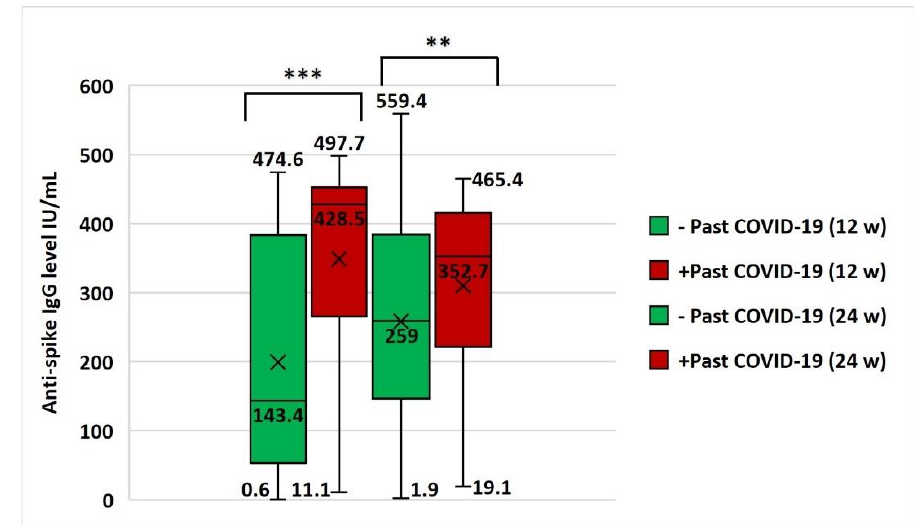
Figure 9. Effect of past COVID-19 infection on antibody immune response after vaccination. Comparison of anti-spike IgG antibody serum level (median and range) between negative ( − ) and positive (+) past COVID-19 infection groups at 12 w and 24 w. Data were analyzed by Mann – Whitney U test and significant differences were defined as *** p < 0.001 and ** p < 0.01. w, week; ×, mean